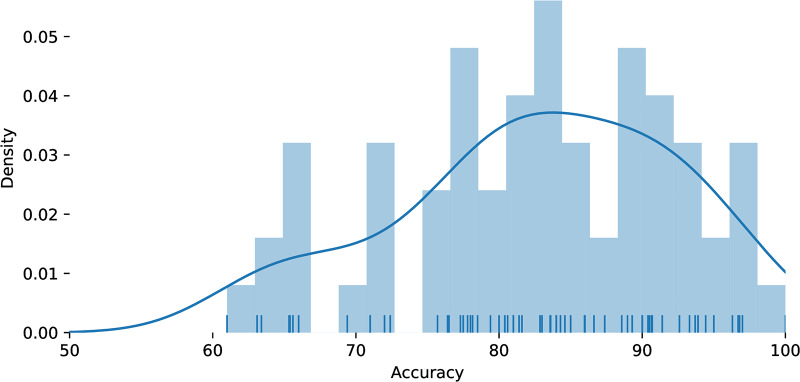
Non-invasive BCI accuracy summary.Summary of per-classification accuracy from many binary non-invasive BCI EEG studies, plotted from the Tables A1-A3 of Lotte et al. [22], including movement intention and mental task imagination BCIs. This figure summarises the accuracy of classifiers used in a large number of brain-computer interfaces, indicating that accuracies vary widely from around 65% to 95% (i.e. there are error rates of 5% to 35%). Where ranges or bounds were given the stated numerical value is used.